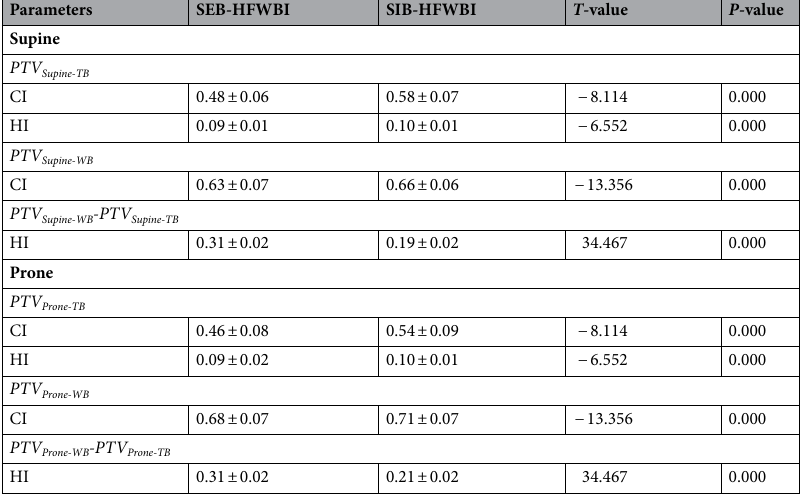
Parameters SEB-HFWBI